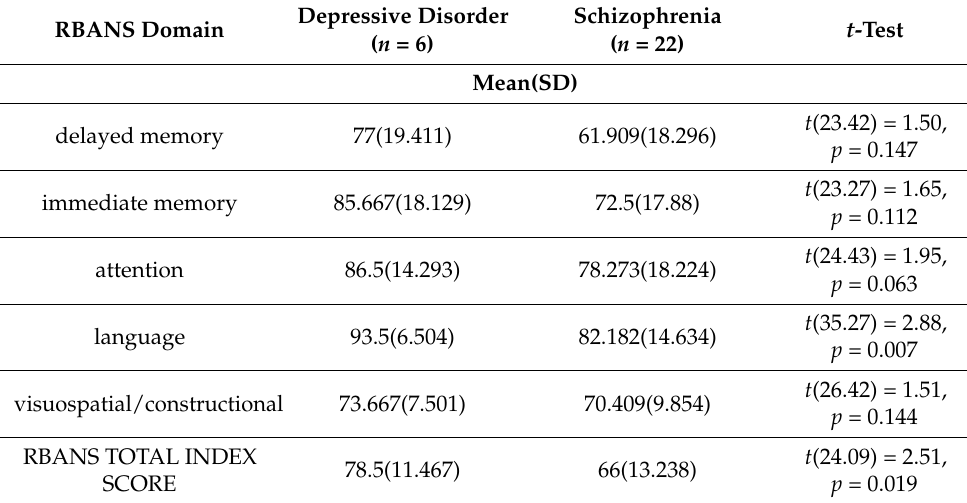
Table 2. Baseline results of RBANS cognitive domains index scores presented separately for both diagnoses and group comparison using an independent t -test.